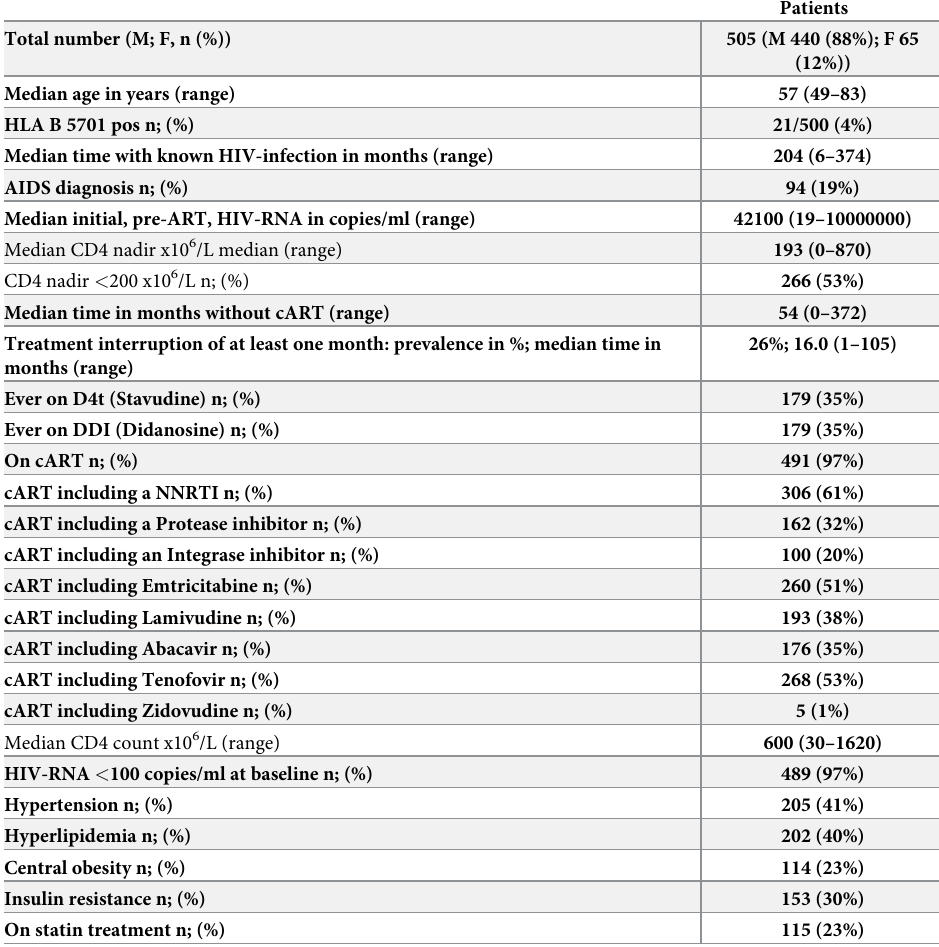
Table 1. Descriptive population data of the patients without diabetes (n = 505) at